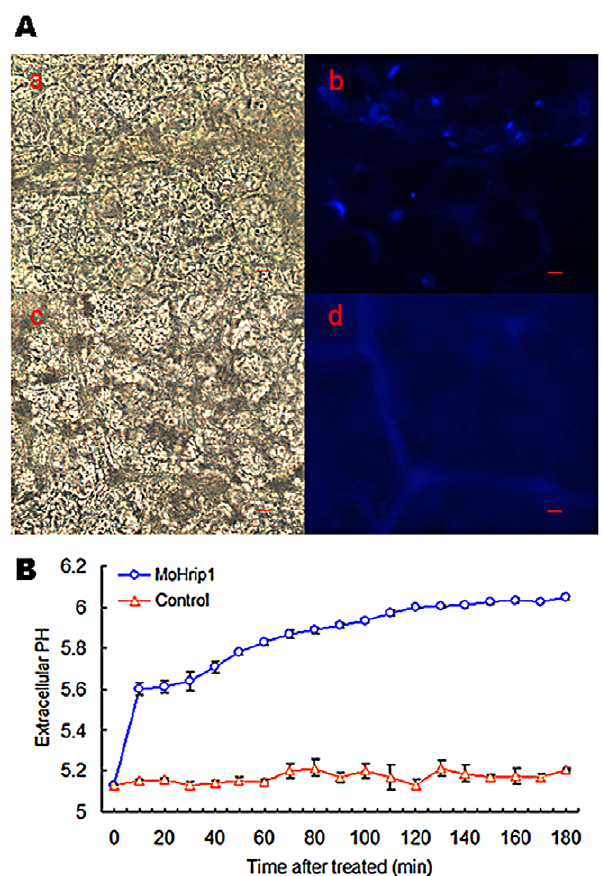
Figure 5. MoHrip1-induced callose deposition and extracellu- lar medium alkalinization in tobacco. A . Callose deposition in tobacco leaves. Tobacco leaves were infiltrated with MoHrip1 (50 m L of a 5 m M solution of MoHrip1) or Mes-NaOH buffer (20 mM, pH 6.0) as a control. After a 24 hour incubation period, the tobacco leaves were bleached to remove their chlorophyll and then stained with aniline blue. The samples were observed under bright-field (a and c) and UV fluorescence (b and d) microscopy. Apparent punctiform callose deposits around the cell wall were photographed in the MoHrip1- treated leaves (b). a and b: MoHrip1-treated leaves, c and d: control. Scale bar=10 m M. B . The kinetics of the extracellular medium alkalinization induced by MoHrip1 in tobacco suspension. A distinct pH increase in the elicitor-treated cell culture was monitored for the first 10 minutes, and the pH stabilized after 100 minutes. Each data point represents three replicates. The error bars represent 6 SD of the